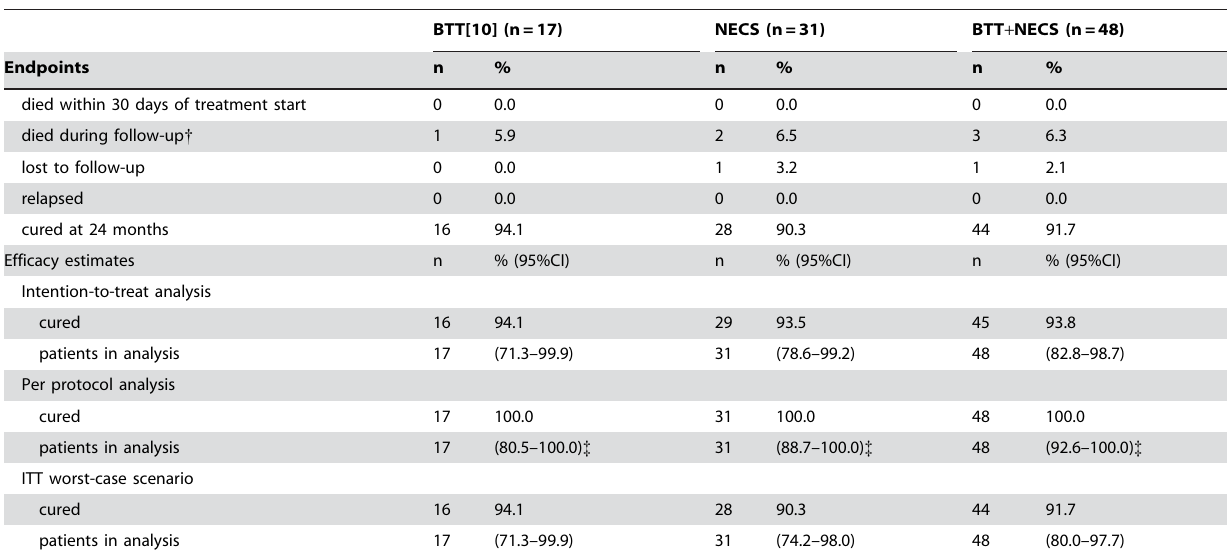
Table 2. Efficacy endpoints and